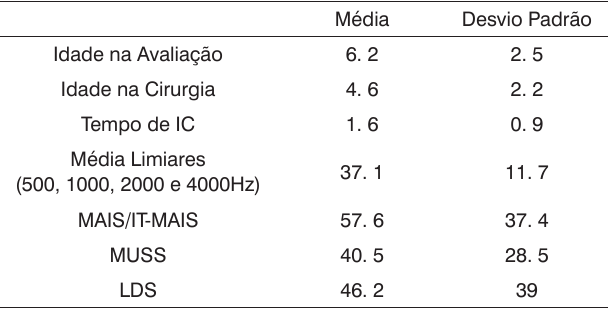
Tabela 1. Informações demográficas dos participantes da pesquisa